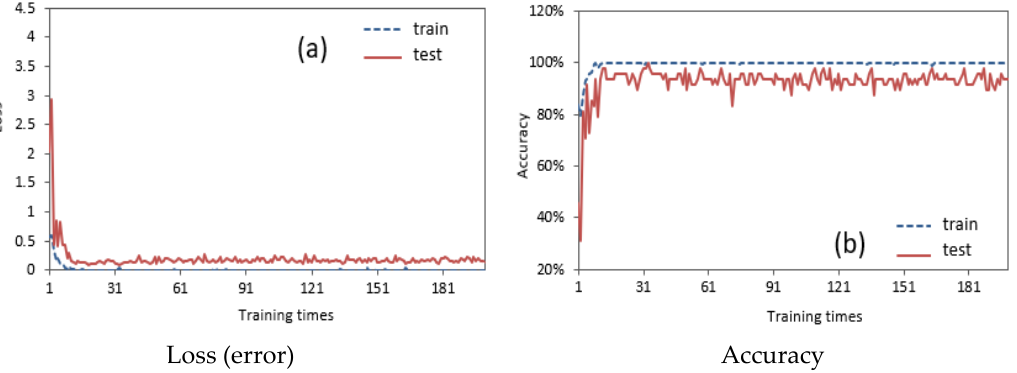
Figure 6. The loss and accuracy of training dataset and test dataset for transfer learning CNN model. The red real lines denote the loss ( a ) and accuracy ( b ) of the test, and the dashed blue lines denote the loss ( a ) and accuracy ( b ) of the training.